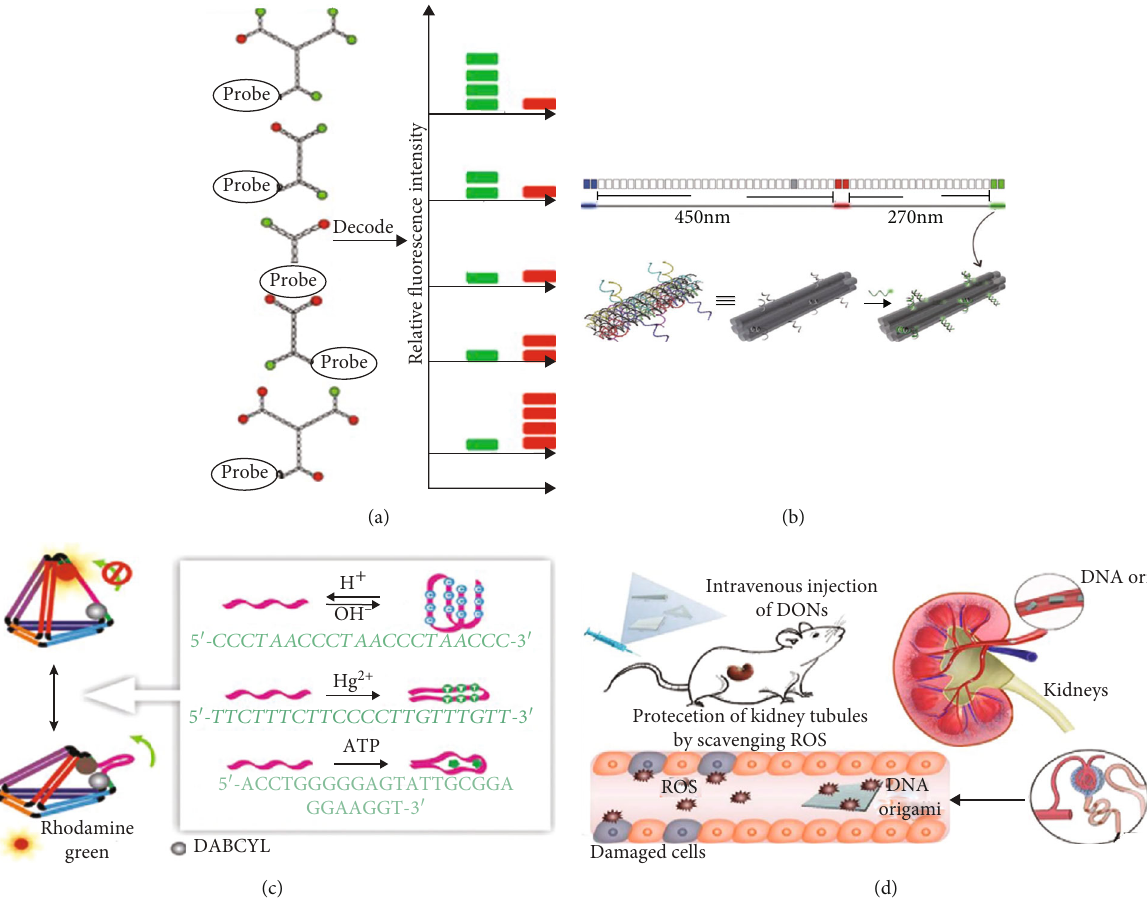
Figure 5: The imaging probe was constructed according to the intensity (a, b) and position (c, d) of fl uorescence molecules. [124, 126 –